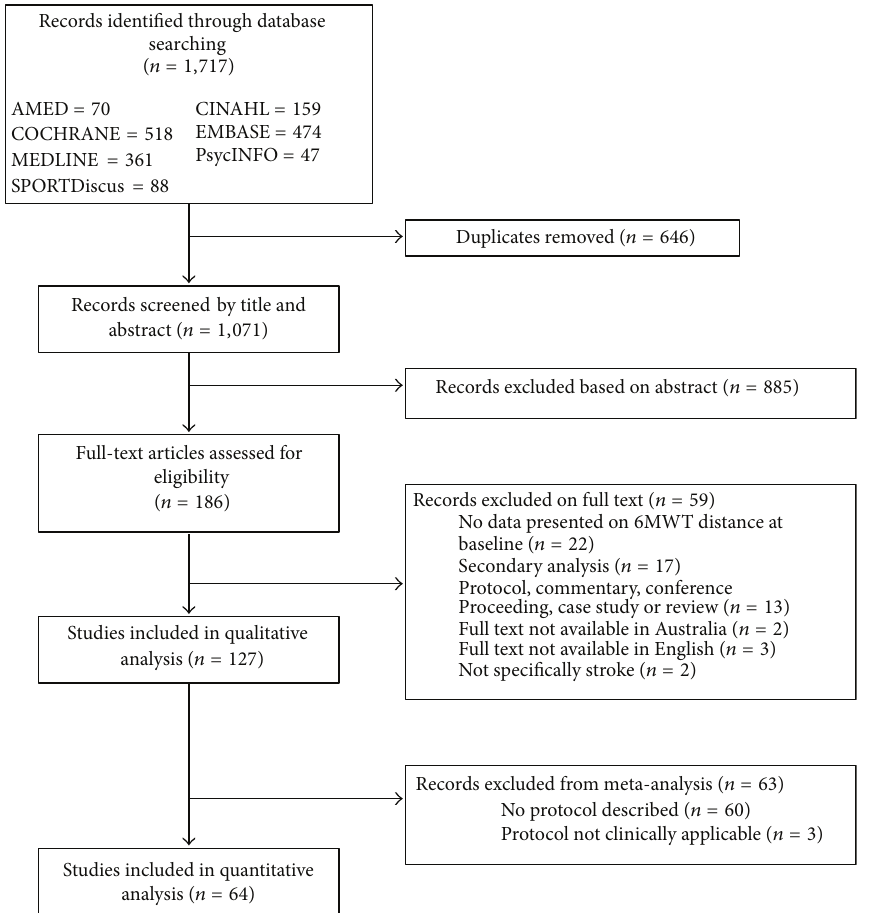
Figure 1: PRISMA flow